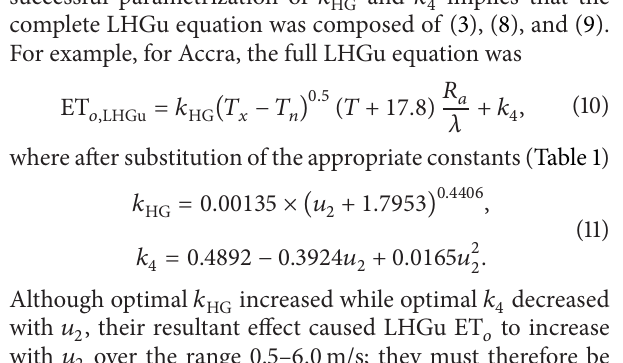
Table 1: Local values for the 𝑘 Location